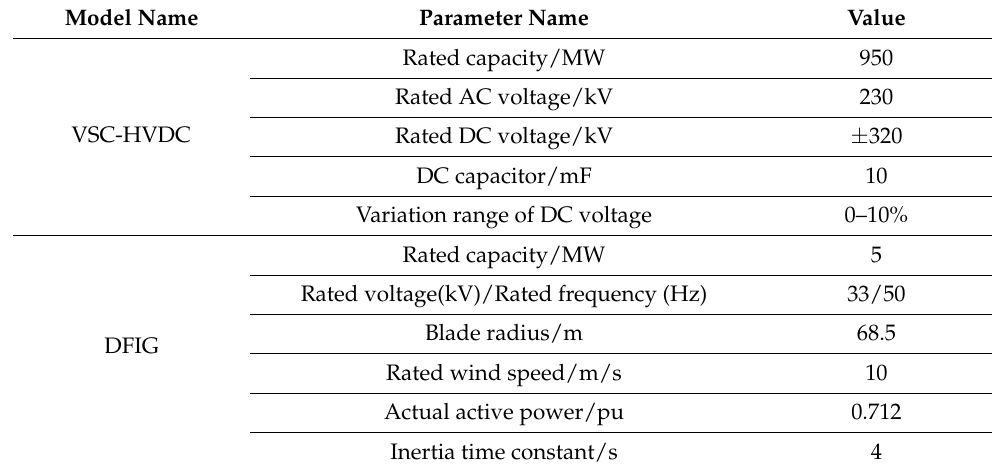
Figure 5. Topology of VSC-HVDC integrated DFIG wind farm. Table 1. Parameters of simulation model.